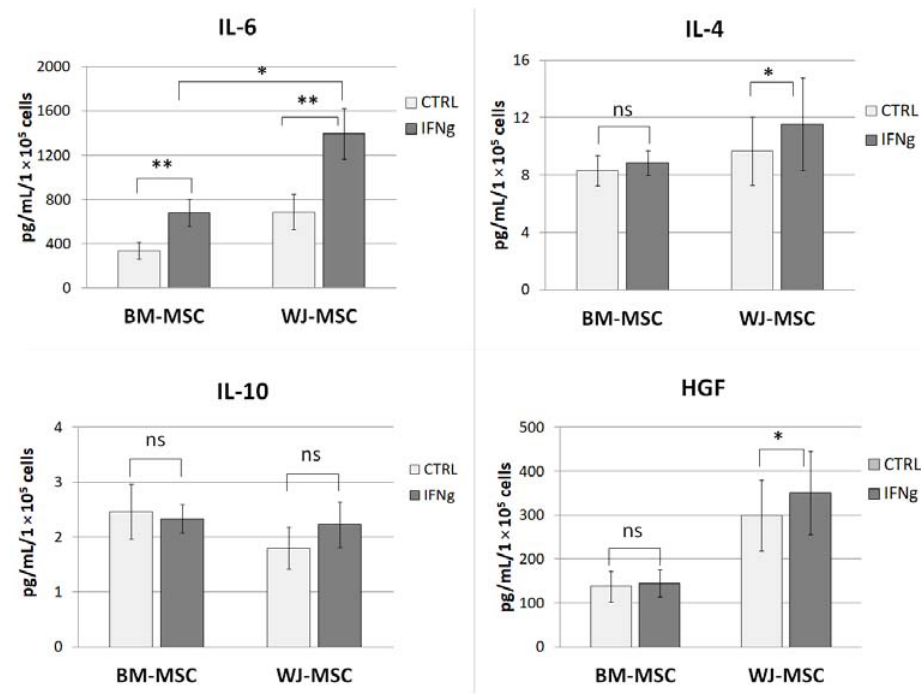
Figure 3. The effect of IFN- γ stimulation on the secretion of selected factors by human BM- and WJ-MSCs by Luminex assay. Bar graphs represent the mean ± SEM concentration of factors in the supernatant adjusted to 1 × 10 5 secreting cells. The comparisons of control (CTRL) vs. IFN γ -stimulated MSCs (IFN γ ) were conducted using Wilcoxon test or T-test for related data (depending on the data distribution, which was determined using Shapiro–Wilk test); the differences between BM-MSCs and WJ-MSCs were analyzed using U Mann–Whitney test or T-test for unrelated data (depending on the data distribution). The normality was checked using the Shapiro–Wilk